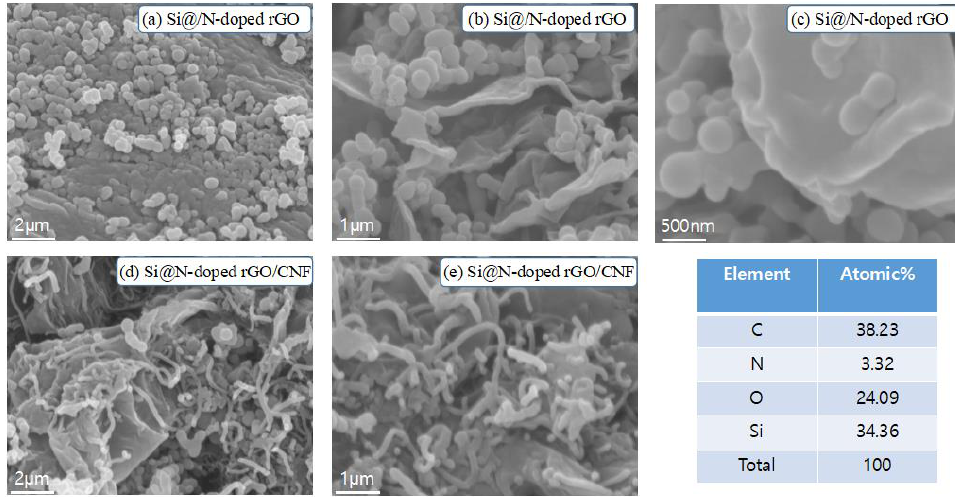
Figure 2. SEM images of the Si@N-doped rGO ( a – c ) and Si@N-doped rGO/CNF ( d , e ) composites and EDS result of Si@N- doped rGO/CNF. and EDS result of Si@N-doped